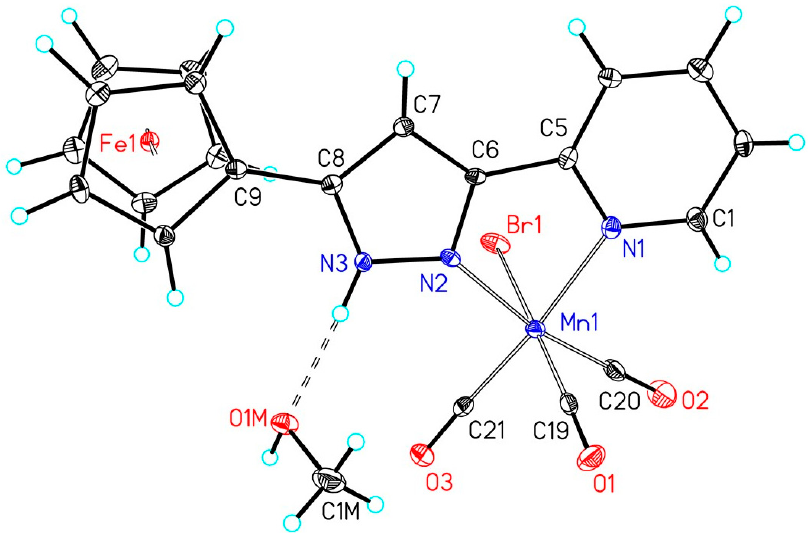
Figure 2. Molecular structure and numbering scheme of 2k ·MeOH. The ellipsoids represent a probability of 30%, H atoms are shown with arbitrary radii. Selected bond lengths are listed in Table 2.